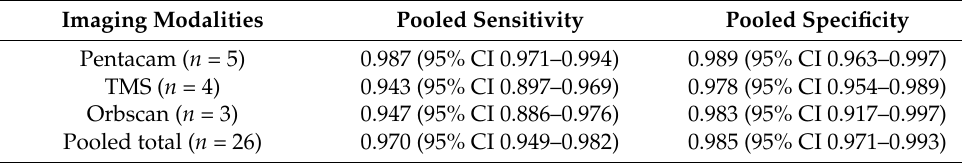
Table 2. Diagnostic performance of artificial intelligence in detection of KC versus controls using different imaging